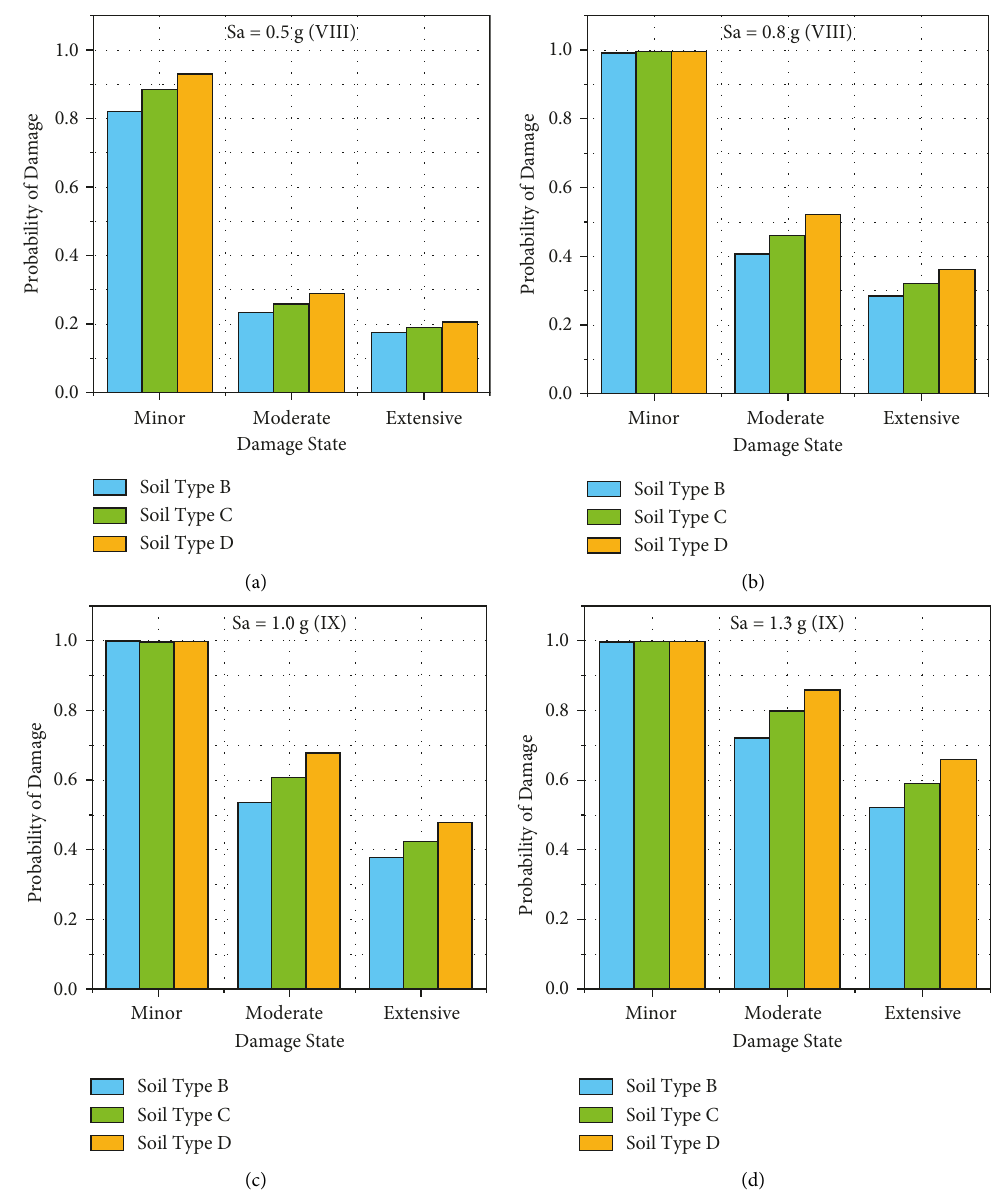
Figure 5: Damage probability for roads with different soil type (P3) for various damage states and seismic